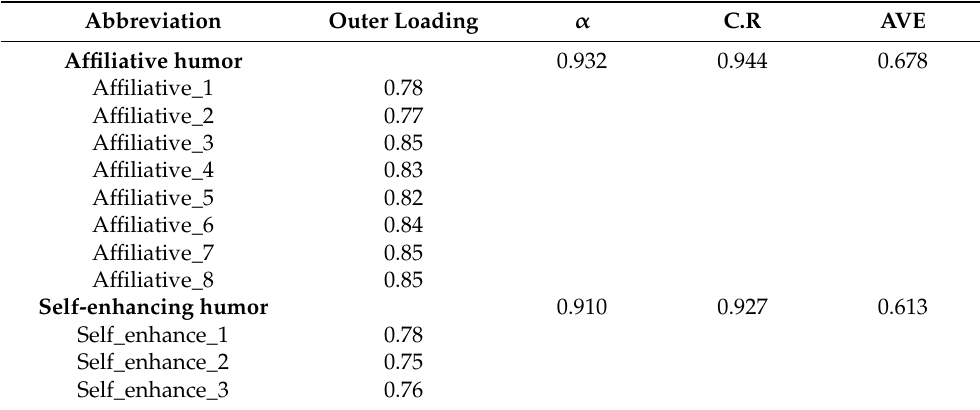
Table 2. Assessment of the formative measurement